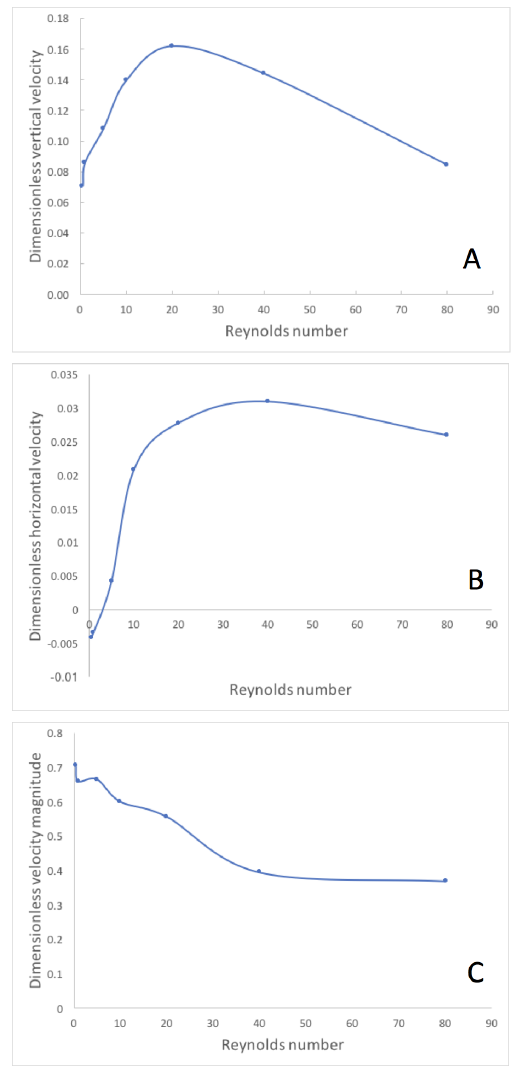
Fig. 10: Temporally and spatially averaged vertical flow above the polyp (A), horizontal flow in the x − direction towards the polyp (B), and velocity magnitude between the tentacles (C) as a function of Re f . Note that the velocities are nondimension- alized by the tentacle length and pulse